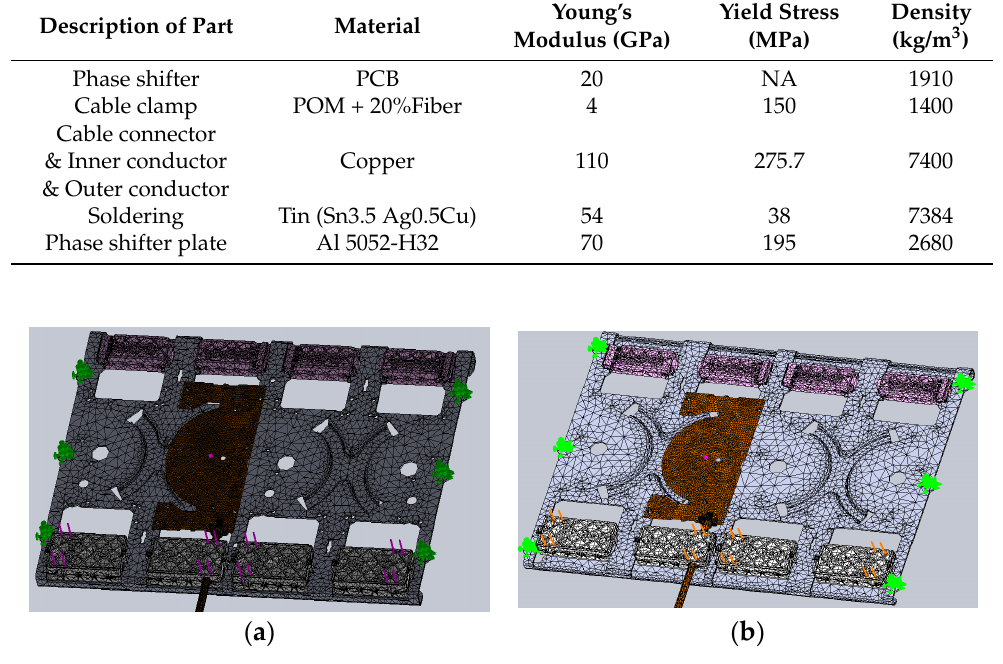
Figure 14. The boundary condition of the original design and the improved design: ( a ) the original design; ( b ) the improved design.